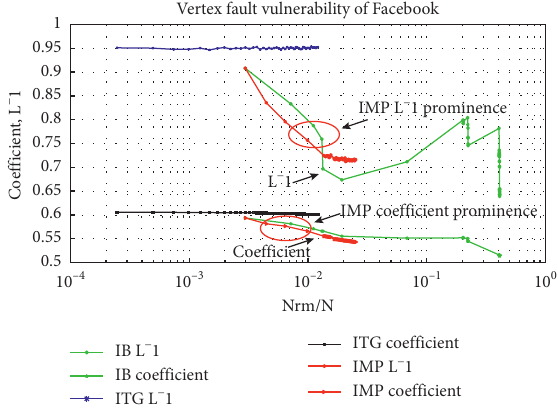
Figure 17: l − 1 & S result of DBLP.